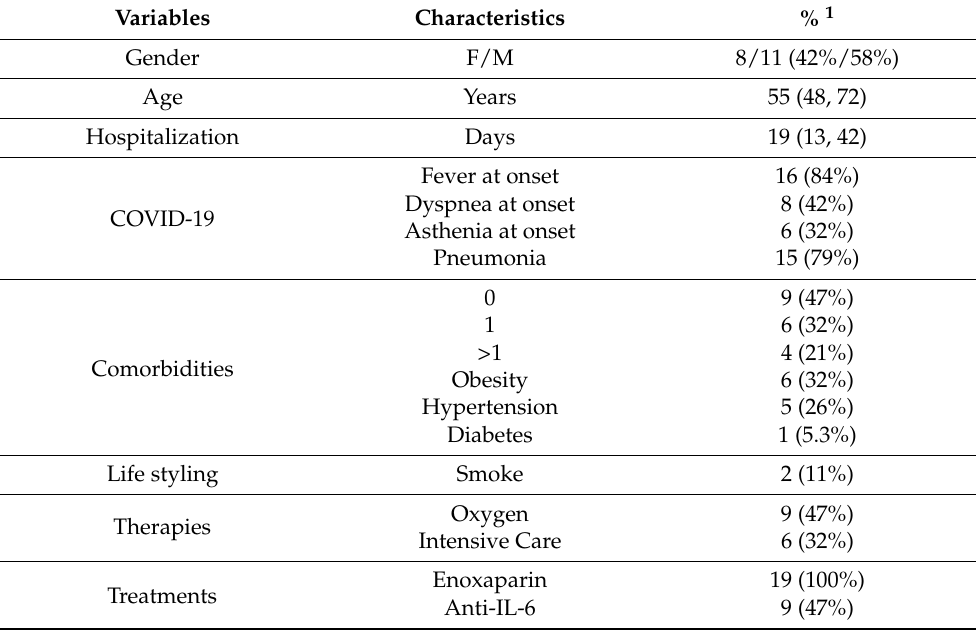
Table 1. Study population. Demographic sum-up, comorbidities, and